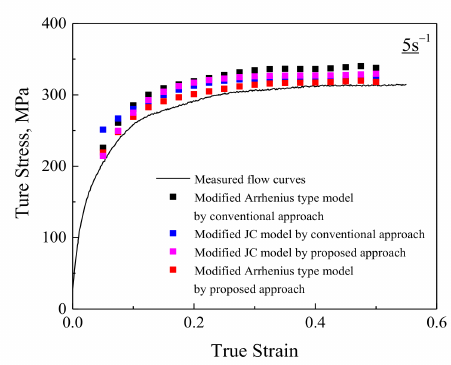
Figure 4. The R and AARE between the measured and calculated values based on different constitu- tive models: ( a ) the modified JC by conventional approach, ( b ) modified JC by considering strain dependency of the parameters, ( c ) modified Arrhenius-type model by conventional approach and ( d ) modified Arrhenius-type model by the proposed approach.